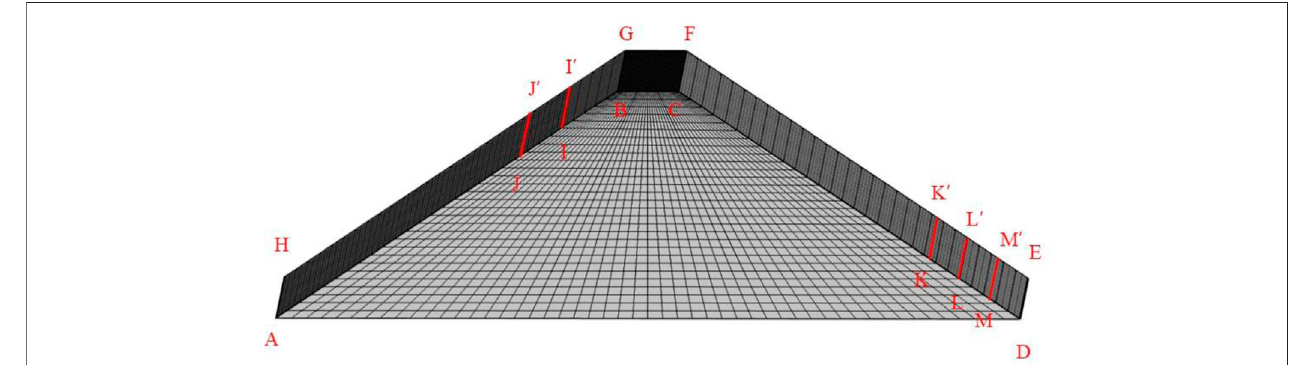
FIGURE 5 | Mesh of the numerical model.